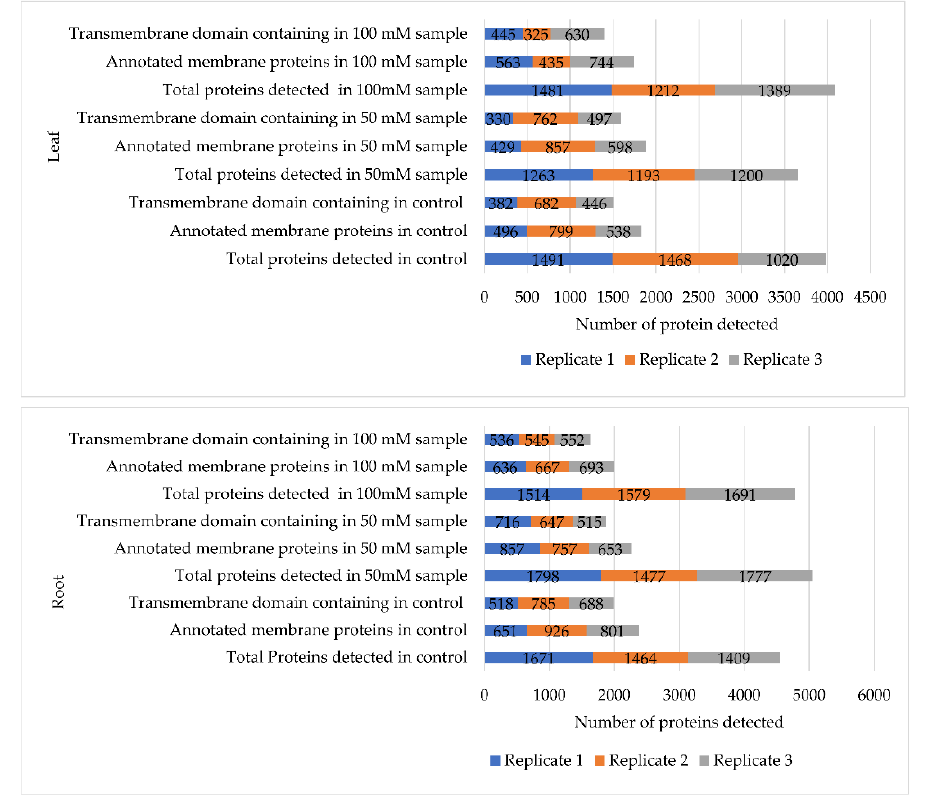
Figure 2. Comparisons of the numbers of total identified proteins against the numbers of transmem- brane domain-containing proteins among all three biological replicates in both leaf (upper panel) and root tissues (lower panel).